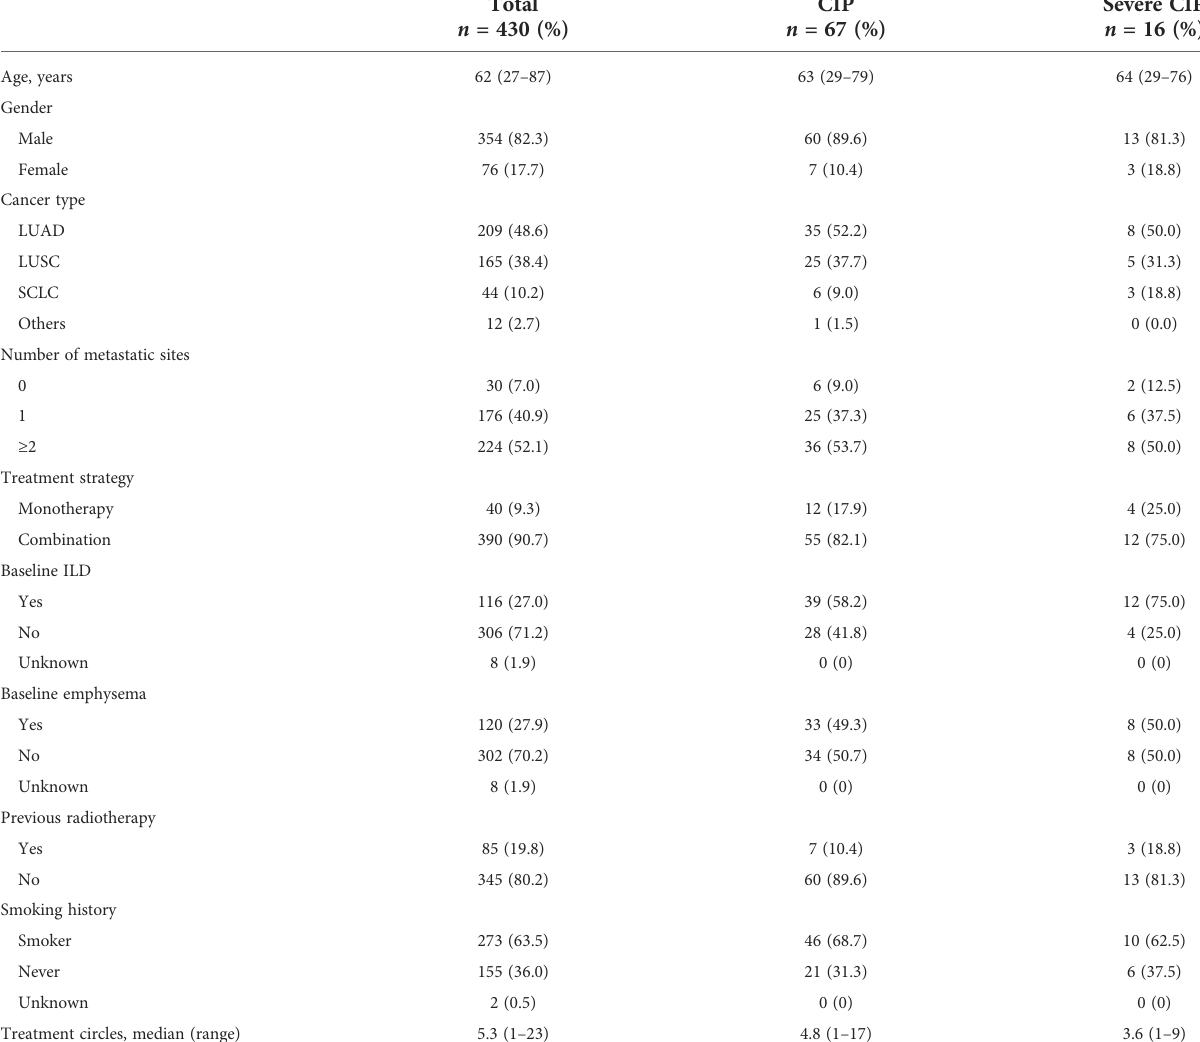
TABLE 1 Baseline characteristic of the enrolled